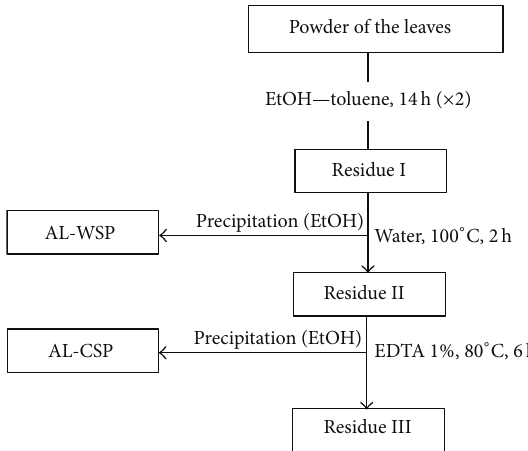
Figure 1: Schematic representation of water-soluble (AL-WSP) and chelating soluble (AL-CSP)